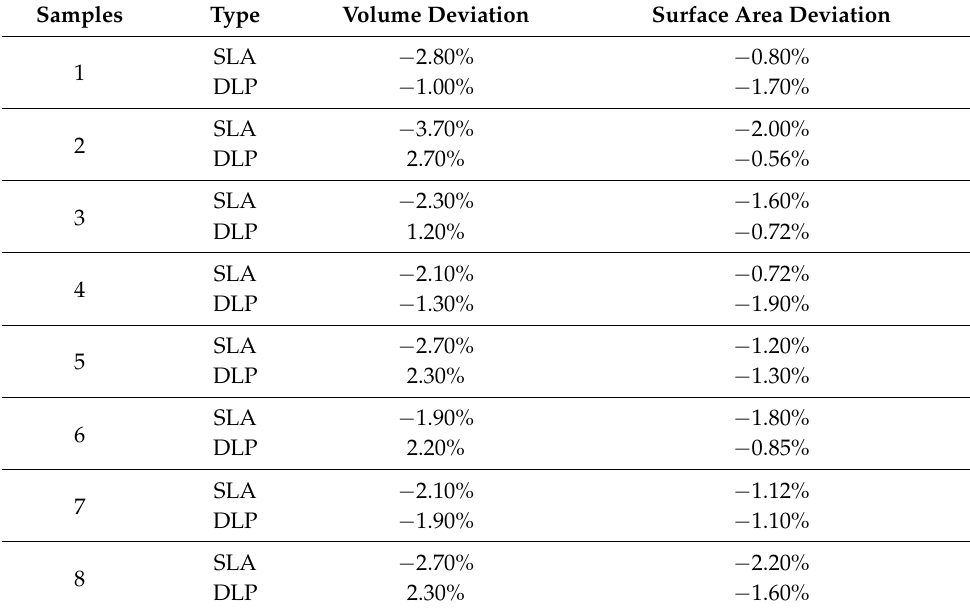
Table 4. The deviations between resin-based aggregates and natural aggregates.